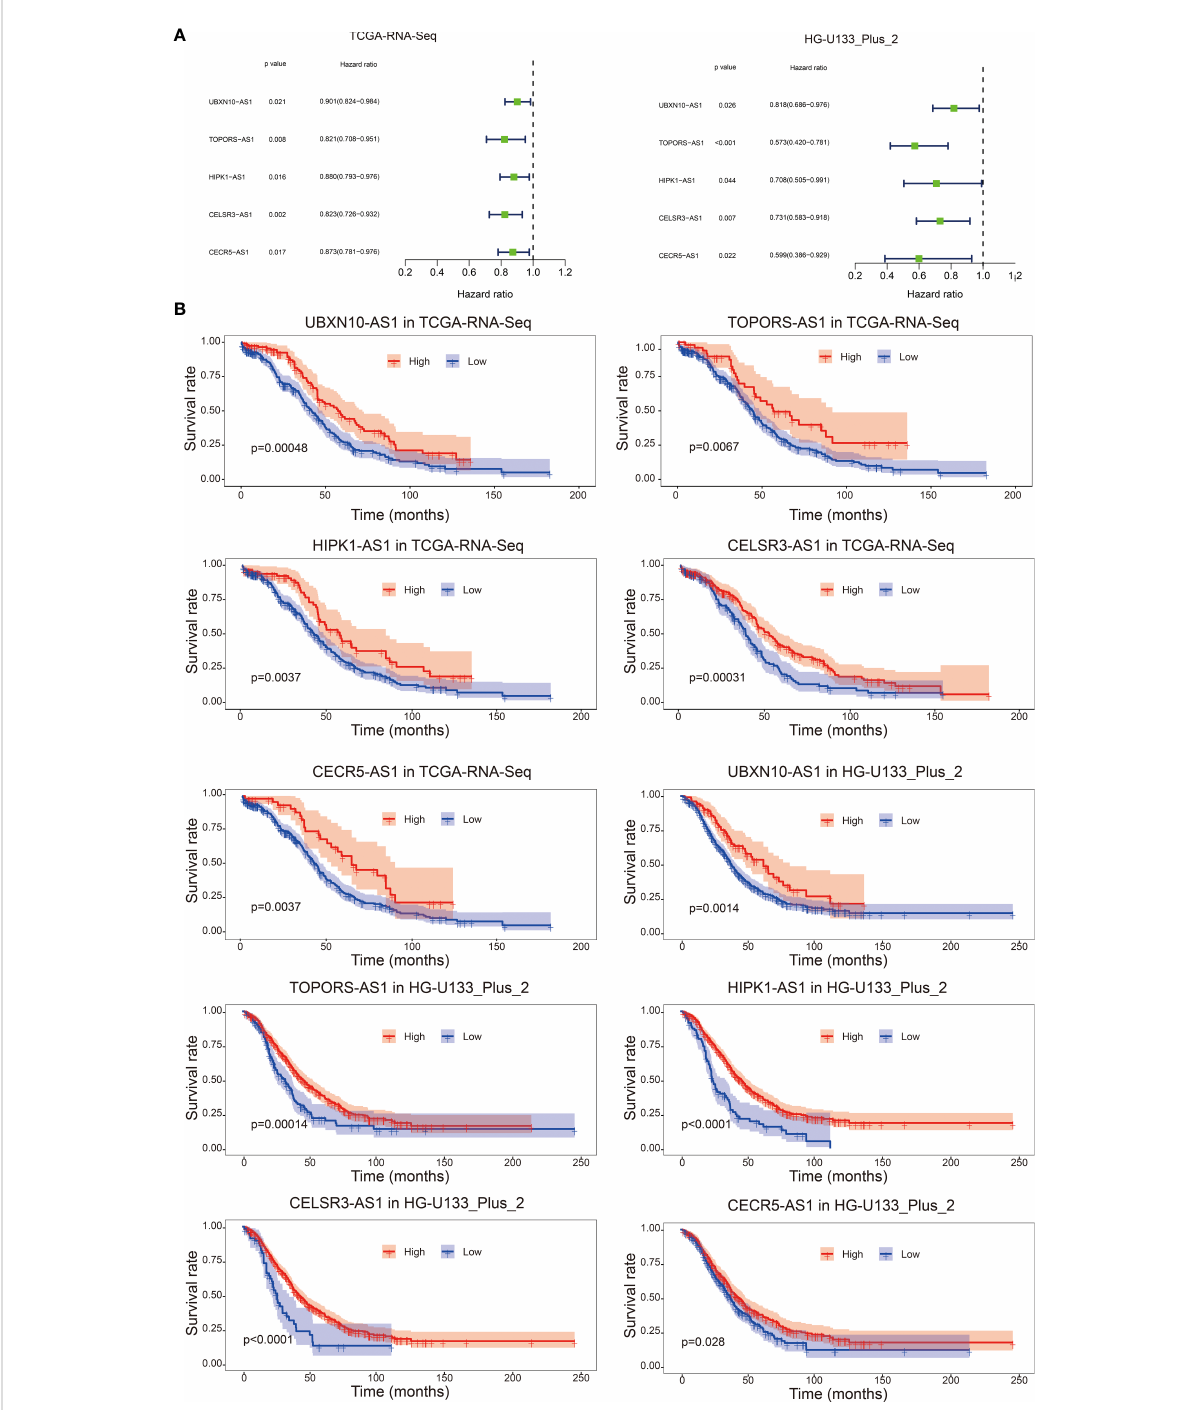
FIGURE 2 Forest plot of the prognostic ability of the fi ve immune-related lncRNAs in TCGA-RNA-Seq cohort and HG-U133_Plus_2 cohort (A) ; Kaplan – Meier curves suggested that expression of the fi ve immune-related lncRNAs were associated with the OS in both TCGA-RNA-Seq cohort and HG-U133_Plus_2 cohort (B)